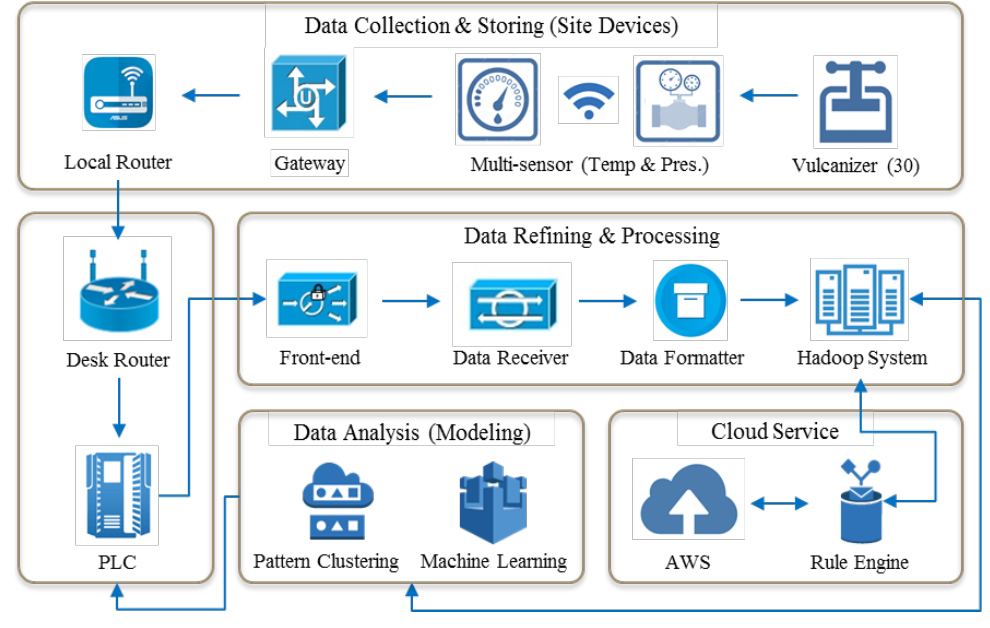
Figure 2. Sensor-based infrastructure.